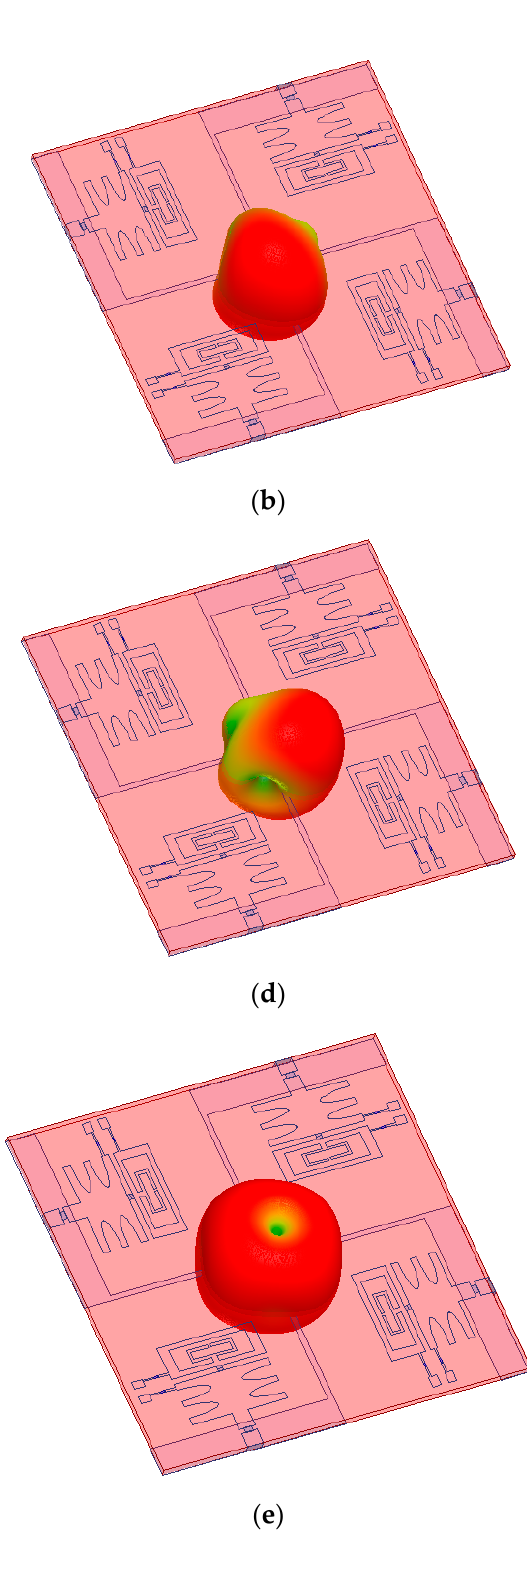
Figure 10. Polar plots of the developed MIMO antenna when: ( a ) port-1 is in the ON state; ( b ) port-2 is in the ON state; ( c ) port-3 is in the ON state; ( d ) port-4 is in the ON state; ( e ) ports-1 to -4 are in the ON state.